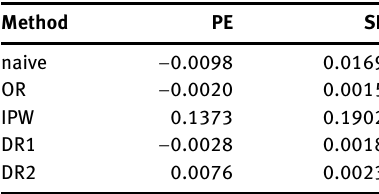
Table 2: Analysis of pneumonia data: point estimates (PE) of θ and bootstrap standard errors (SE) obtained using different methods (see Section 3.2 for